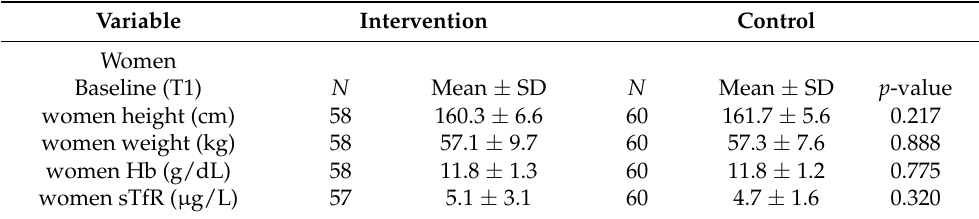
Table 1. Health indicators of childbearing age women (15–49 years) and their toddlers (6–23 months) in intervention and control groups across